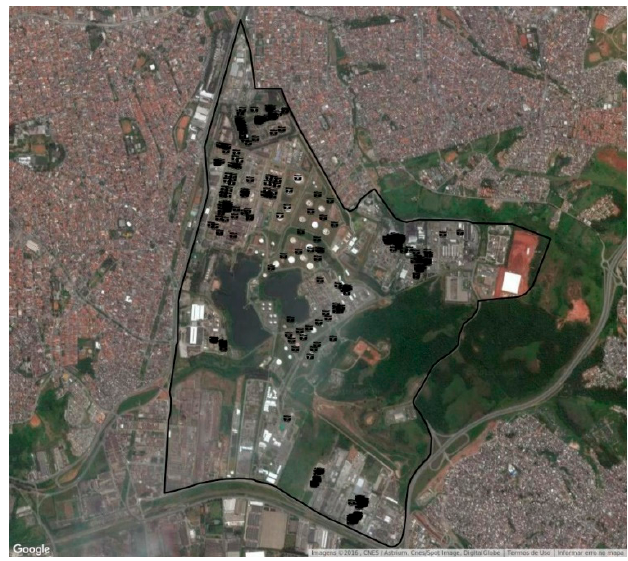
Figure 1. Satellite image showing the CPC area and evaporative emission sources in black.